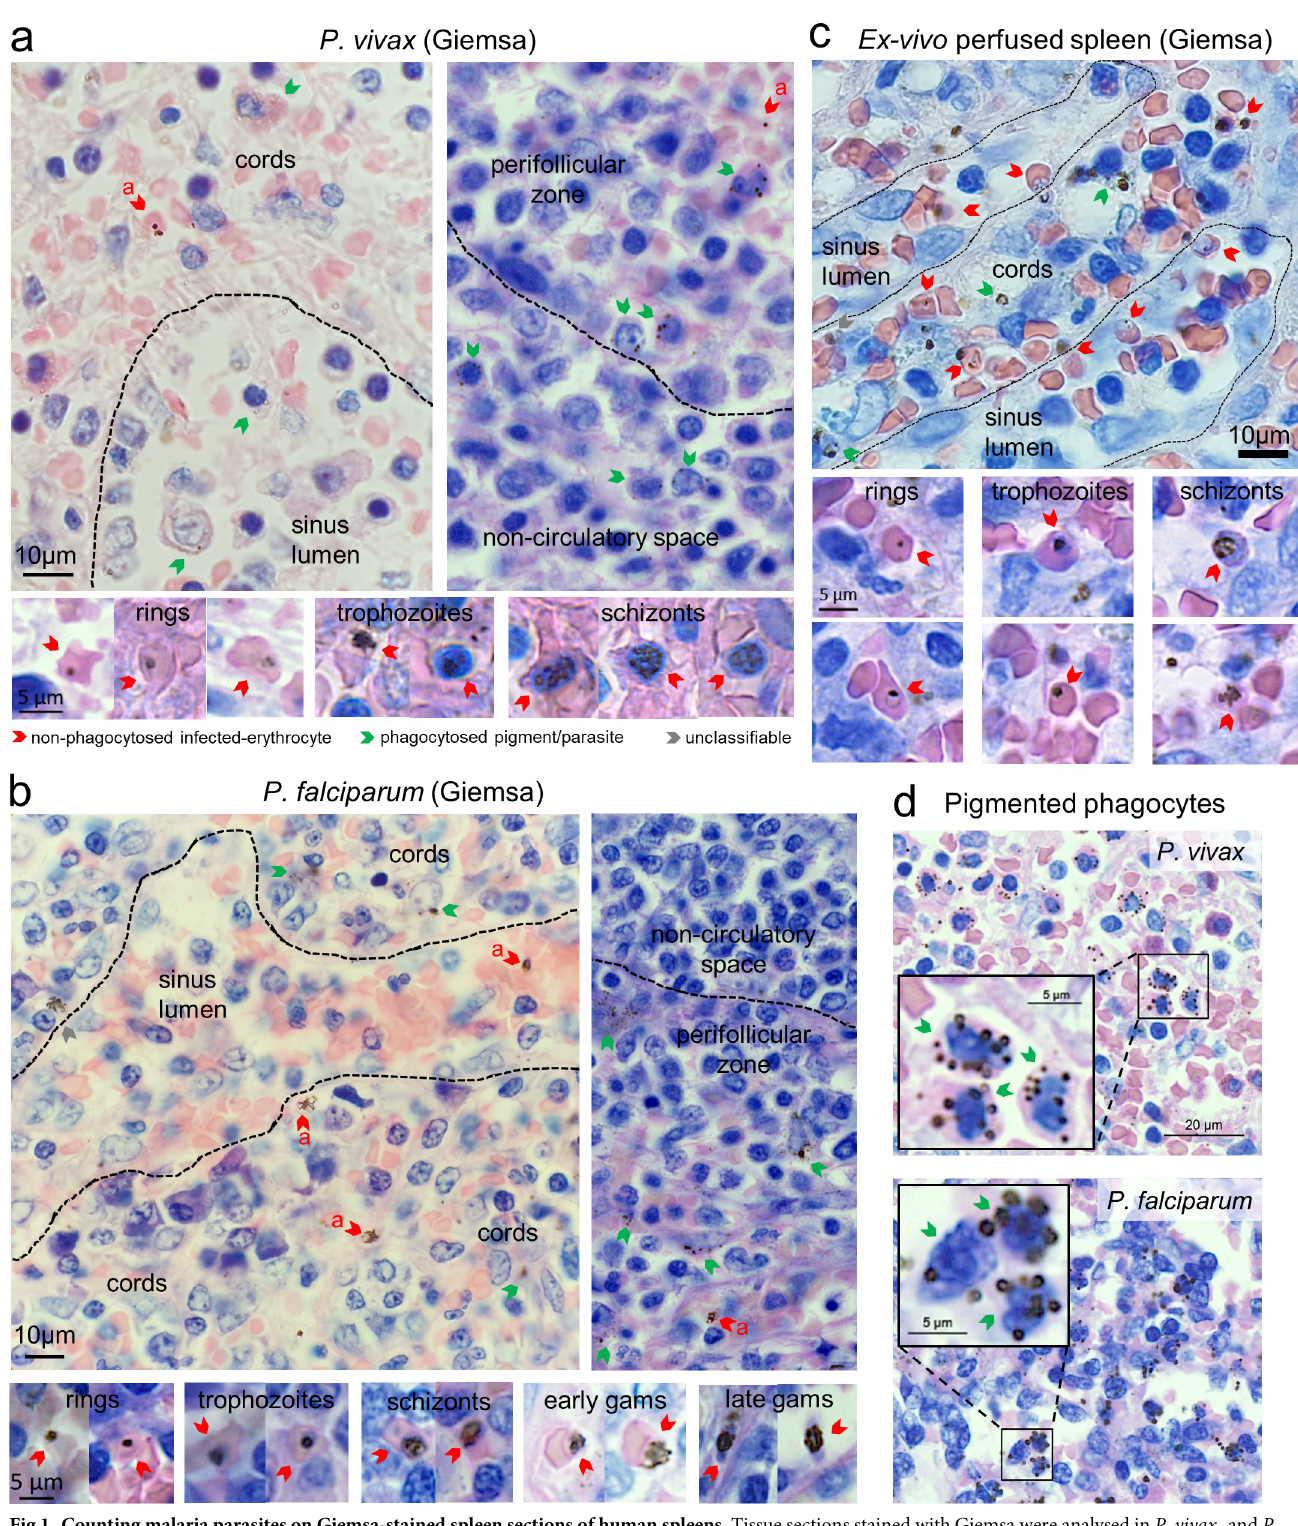
Fig 1. Counting malaria parasites on Giemsa-stained spleen sections of human spleens. Tissue sections stained with Giemsa were analysed in P . vivax - and P . falciparum -infected spleens at 400 × magnification using a Carl Zeiss AxioScan Z1. Representative P . vivax -infected spleen sections are from patient #1 and P . falciparum from patient #17, with staging key of non-phagocytosed P . vivax and P . falciparum shown below these panels (a, asexuals) (a, b). Tissue compartments